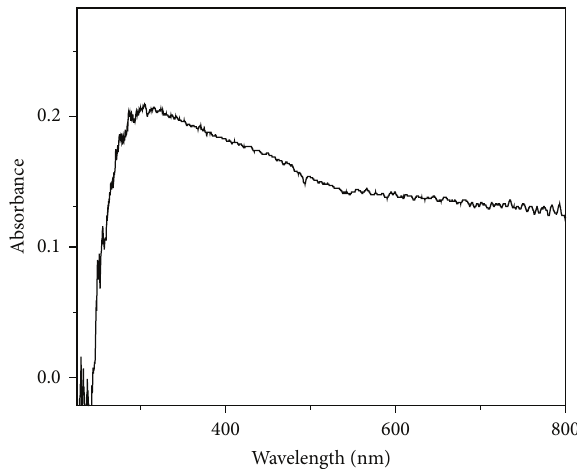
Figure 6: UV-Vis absorbance spectra of microwave synthesized ZrO 2 sample calcinated at 400 ∘ C.